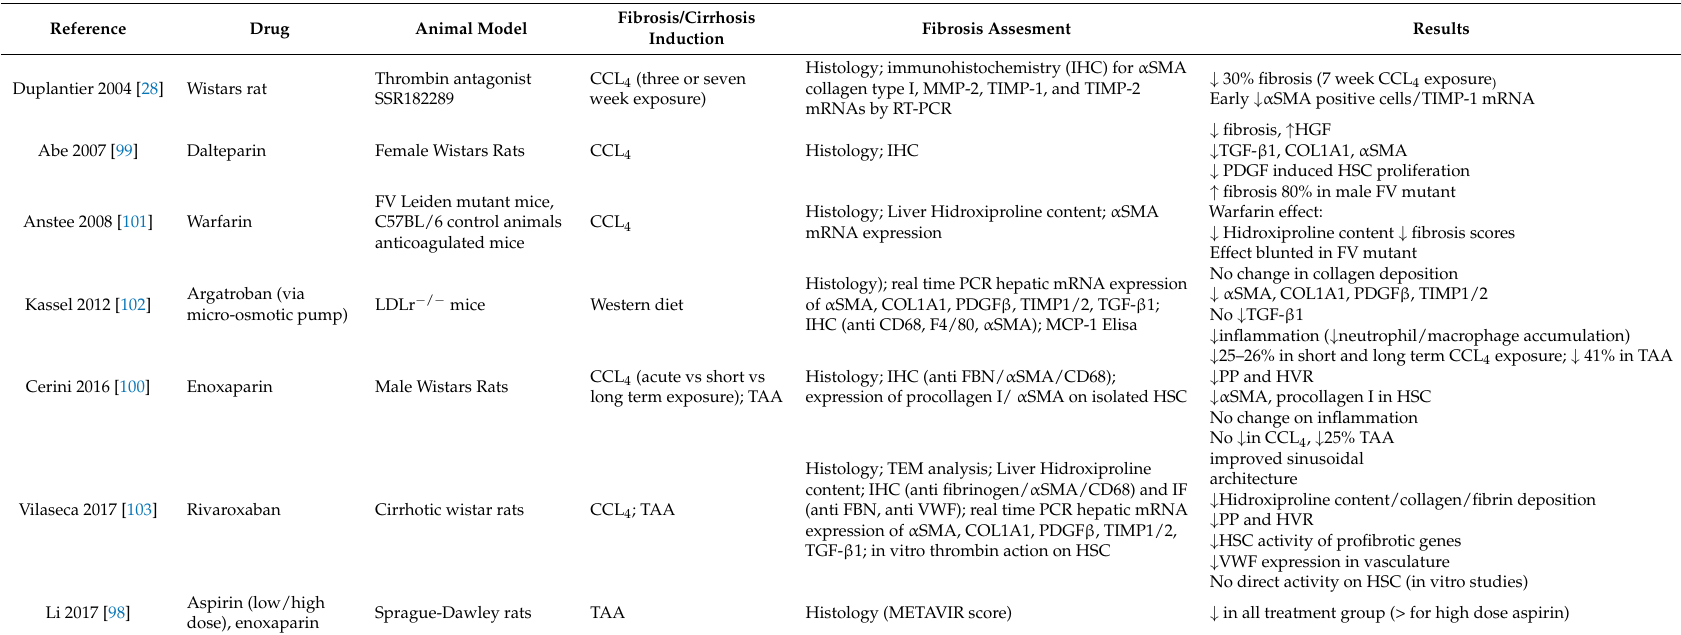
Table 2. Main studies exploring anticoagulant-antifibrotic